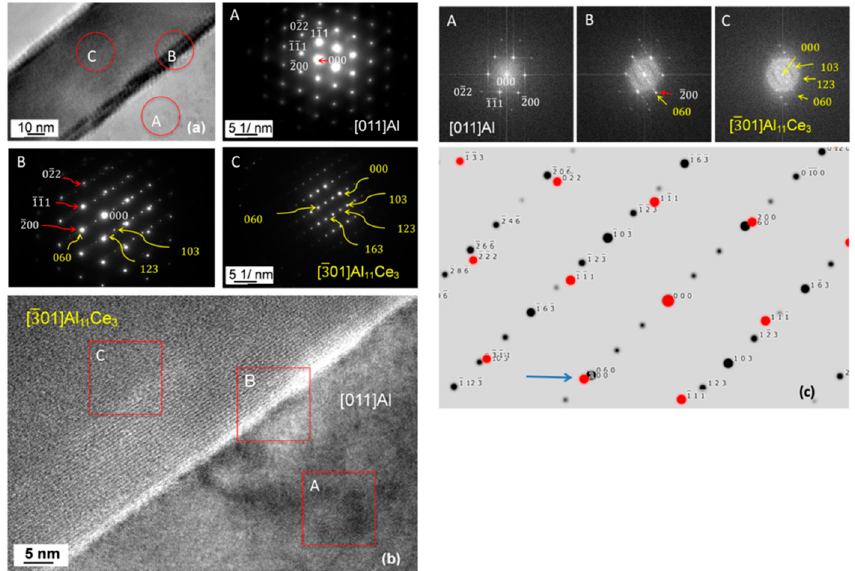
Figure 16. Structure of the interface between the Al 11 Ce 3 lamella and Al having an orientation relationship: (cid:4670)0 1 1(cid:4671) Al ║ (cid:4670)3(cid:3364) 0 1(cid:4671) Al11Ce3 with (cid:4666)2(cid:3364) 0 0(cid:4667) Al ║ (cid:4666)0 6 0(cid:4667) Al11Ce3 : ( a ) TEM bright field image and SAD patterns from Al (A), interface (B) and Al 11 Ce 3 (C); ( b ) HRTEM image of the interface with corresponding FFT patterns A, B, C from individual phases and interface region; ( c ) simulated diffraction pattern showing an orientation relationship between Al and Al 11 Ce 3 . Alloy: Al–5Ce.